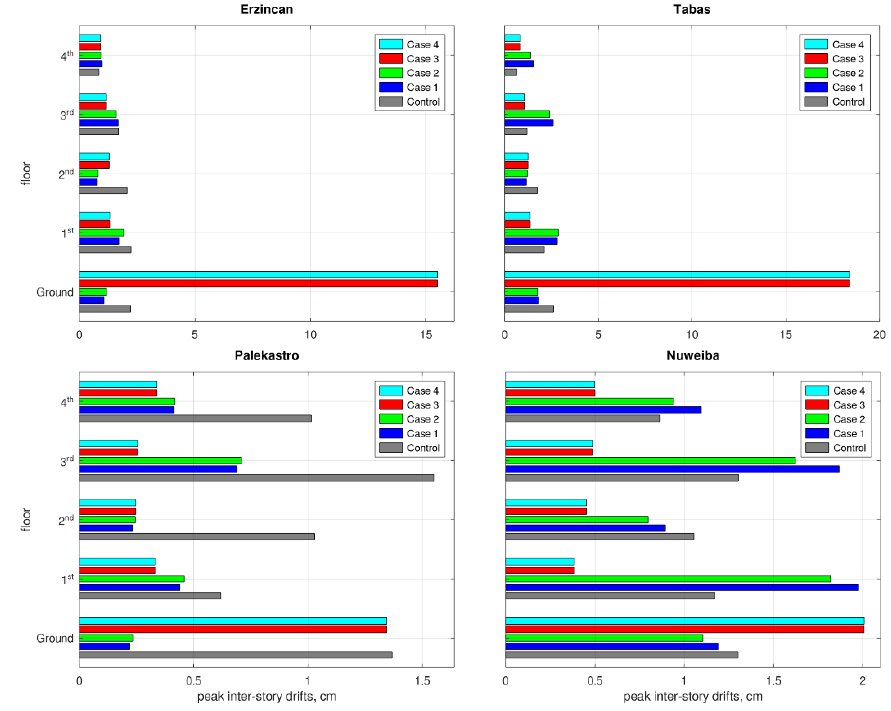
Figure 8. Peak inter-story drift responses to each earthquake.